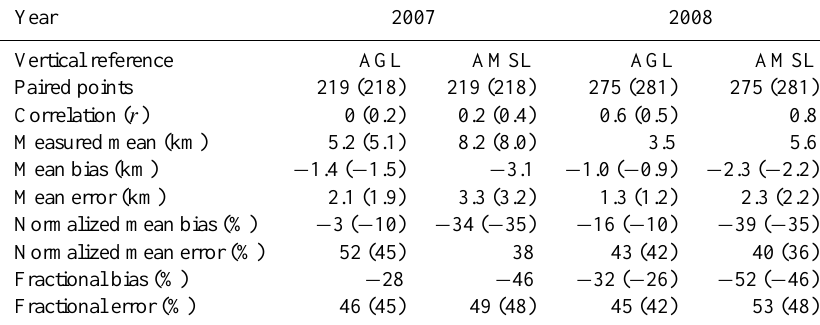
Table 5. Plume top height model comparisons with CALIOP for the FEPS plume-rise scenario (SMOKE plume-rise scenario shown in parentheses when different). Please note that some plumes contribute multiple paired